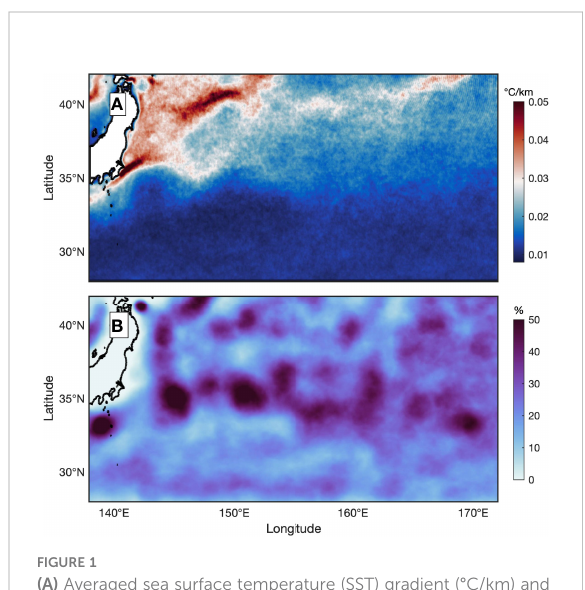
FIGURE 1 (A) Averaged sea surface temperature (SST) gradient (°C/km) and (B) averaged eddy occurrence (%) in the Kuroshio Extension (KE) region. In (B) , the averaged eddy occurrence for each pixel is equal to the number of days the eddy exists divided by the total number of